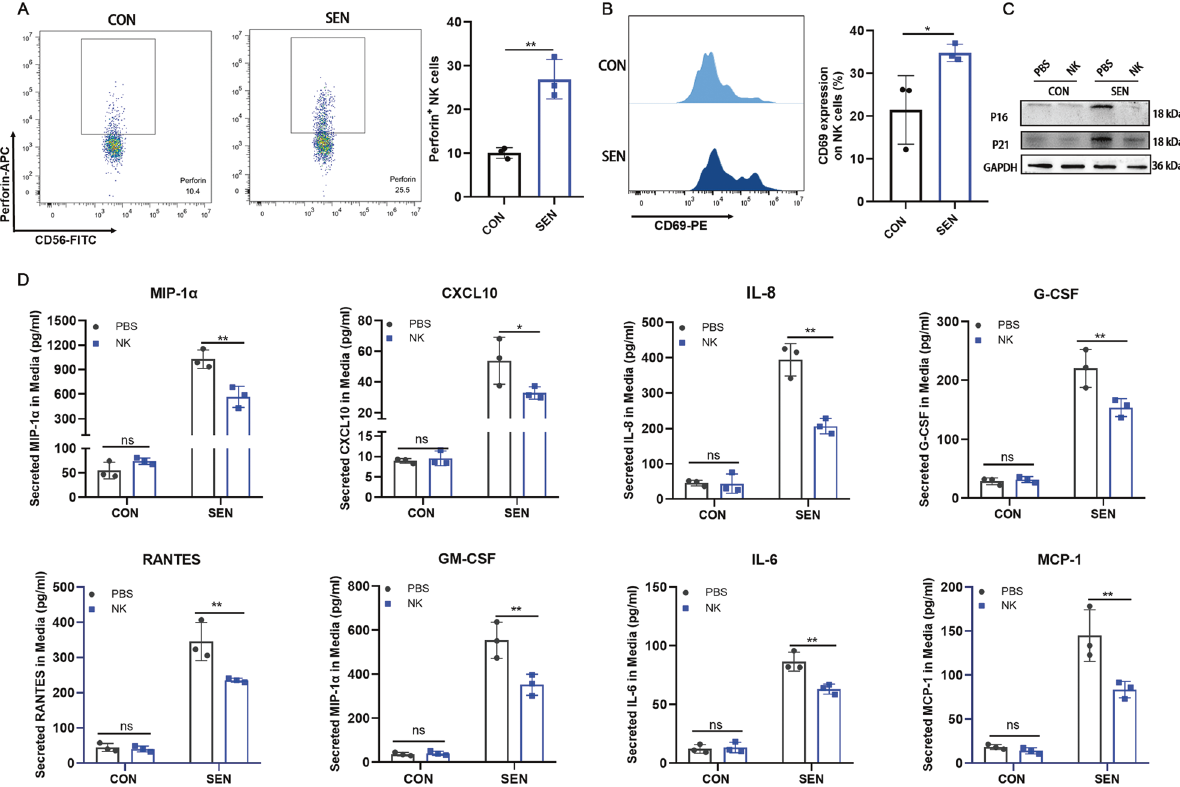
Fig. 2 NK cells reduce senescent markers and decrease the SASP phenotype in human adipose tissue. Flow cytometry to detect expression of ( A ) perforin and ( B ) CD69 was performed after 48-h co-incubation with NK cells and human adipose tissue, treated with conditional medium from control (CON) or senescent (SEN) preadipocytes for 24 h. Cells were gated in CD3 - CD56 + location. n = 3. Data are presented as means± SD. Differences were assessed by the two-tailed unpaired nonparametric t -test. * P <0.05, ** P <0.01. C Senescent markers for P16 and P21 were detected by Western blotting. n = 3. D Secreted proin fl ammatory cytokines in conditional medium from adipose tissue was collected 48-h after removing the NK cells. n = 3. Data are presented as means±SD. Differences were assessed by the two-way ANOVA test. ns P >0.05, * P <0.05, ** P <0.01. Two parallel samples were set in each experiment and three independent experiments were performed for each